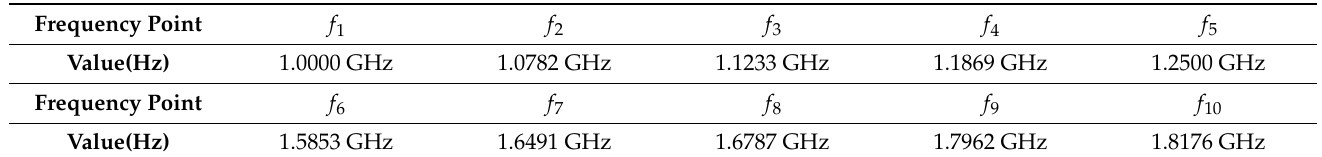
Table 2. Radar system carrier frequency optimization